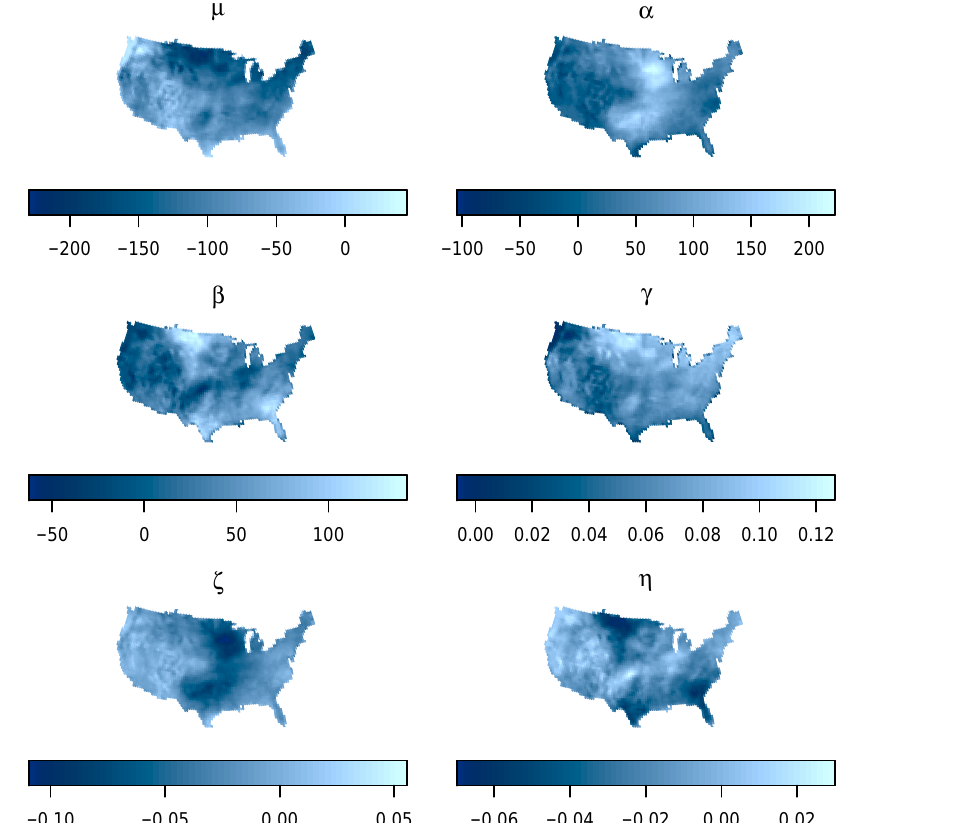
Figure 2. Heat maps of the estimated regression coefficients for the ASL models fitted to the mini-experiment 1 data. The parameter being estimated is indicated above each plot (cf. Eq. 3). This figure demonstrates the continuity of the estimated coefficients across space, as required by Assumption